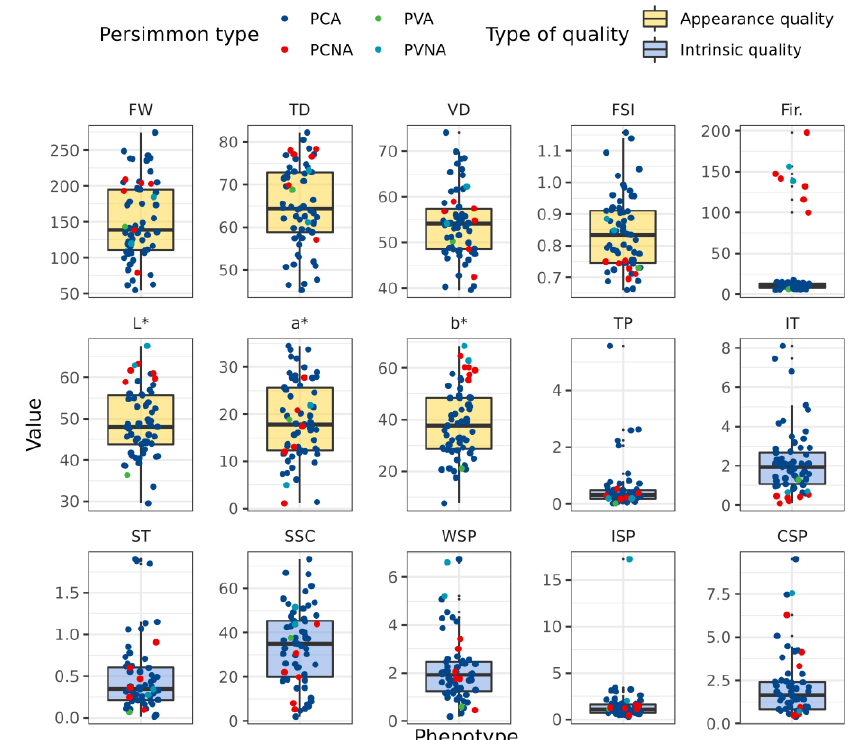
Figure 3. The variation analysis on the indexes of different fruit quality among persimmon germplasms. Note: FW: Fresh weight; TD: Transverse diameter; VD: Vertical diameter; FSI: Fruit shape index; Fri.: Firmness; TP: Total polyphenols; IT: Insoluble tannin; ST: Soluble tannin; SSC: Soluble sugar content; WSP: Water soluble pectin; ISP: Ironic soluble pectin; CSP: Covalent soluble pectin.